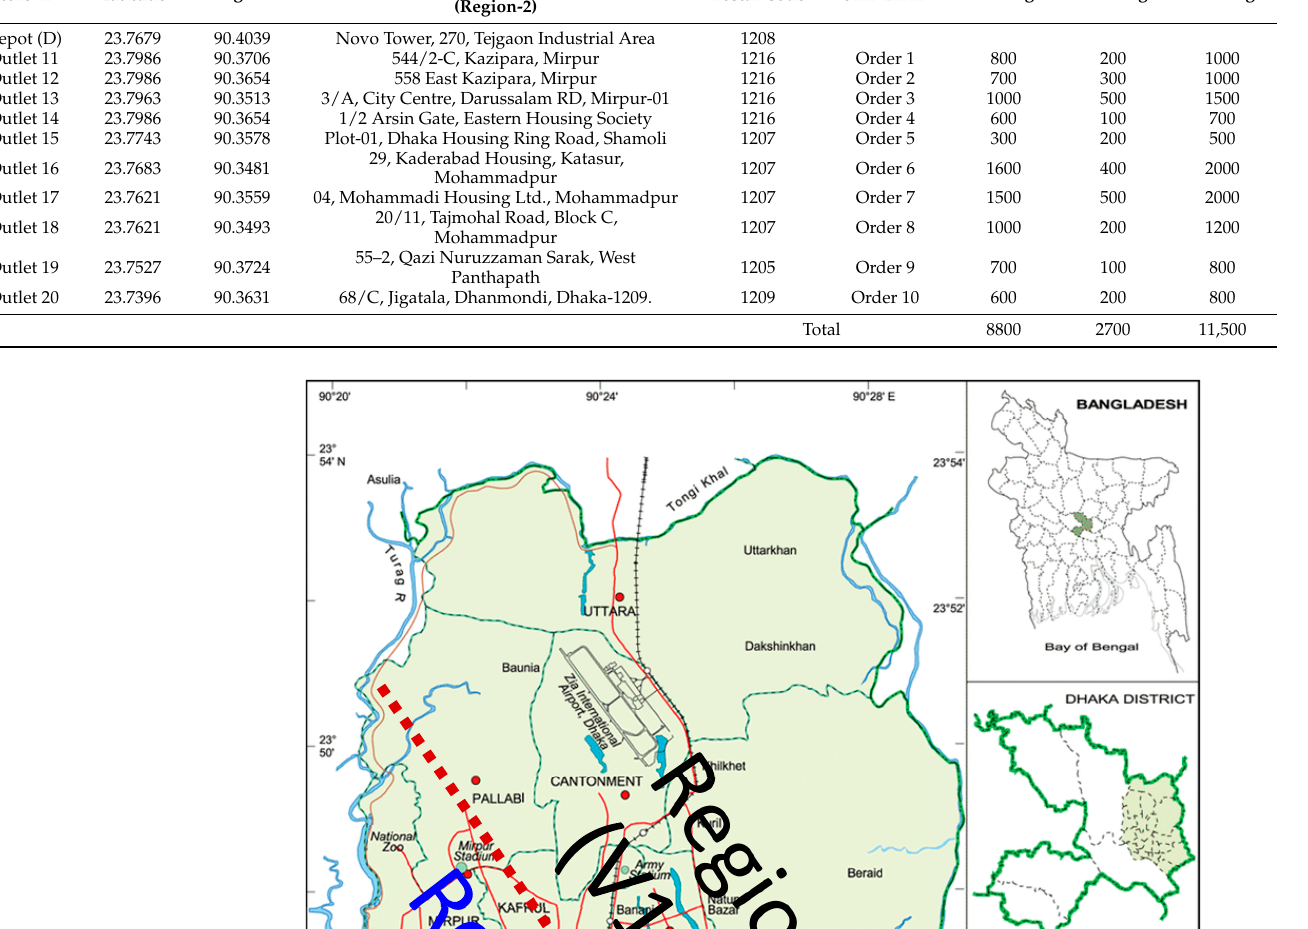
Table 2. Depot (Warehouse) and Delivery Locations (Outlet) information in Region-2 for assignment of vehicle 3 and 4. Store ID Latitude